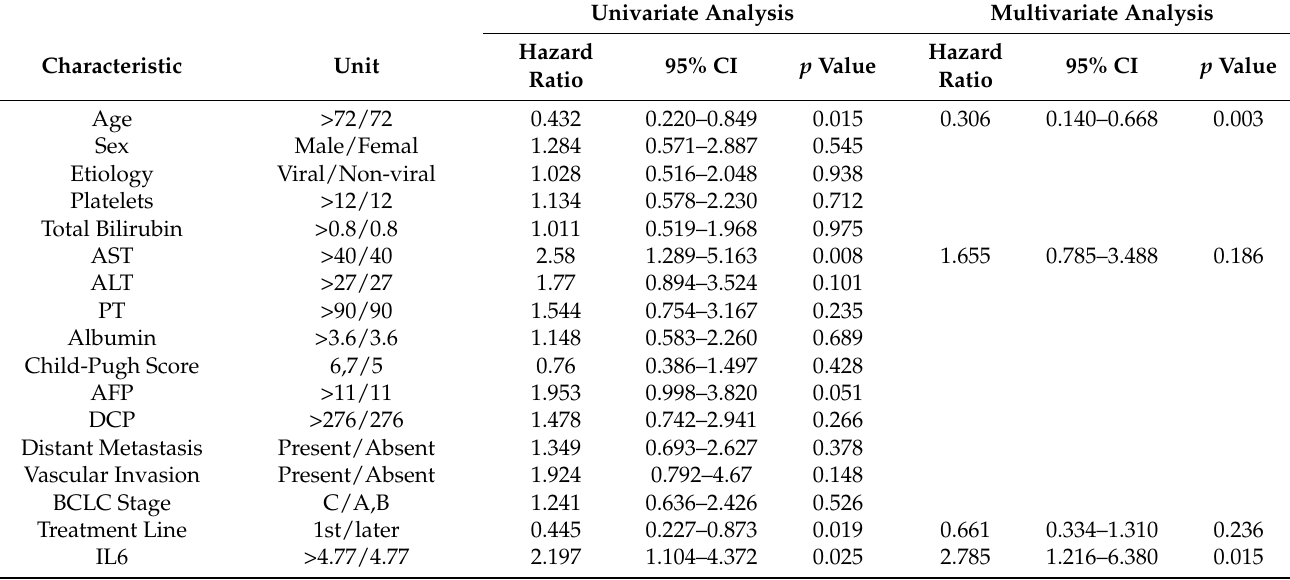
Table 4. Cox proportional hazards analysis of factors related to PFS. Univariate Analysis Multivariate